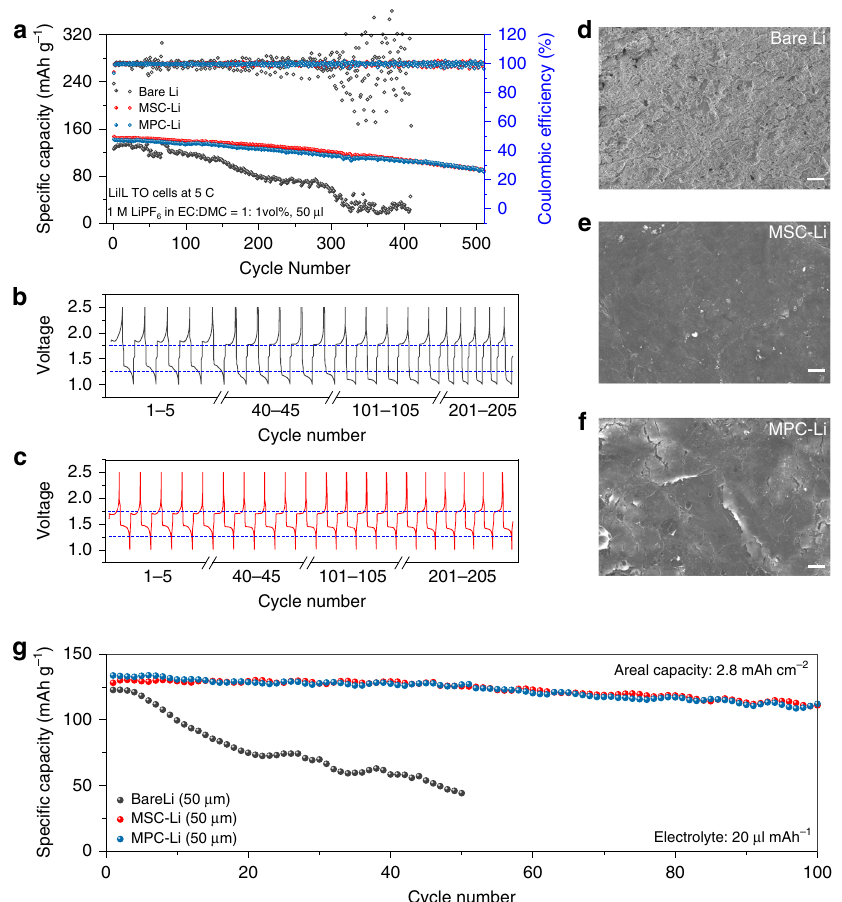
Fig. 4 Electrochemical performances of Li|LTO cells at 5 C and Li|LCO cells at 0.5C. a Galvanostatic cycling performances of cells using Li 4 Ti 5 O 12 as cathode and bare Li, MSC-Li or MPC-Li as anode. b , c Voltage curves of bare Li ( b ) and MSC-Li ( c ) at different cycles. d – f , Surface morphologies of bare Li ( d ), MSC-Li ( e ), and MPC-Li ( f ) anodes after 400 cycles. g Galvanostatic cycling performances of cells using LiCoO 2 as cathode and 50 μ m thick bare Li, MSC-Li or MPC-Li as anode. Scale bars: 50 μ